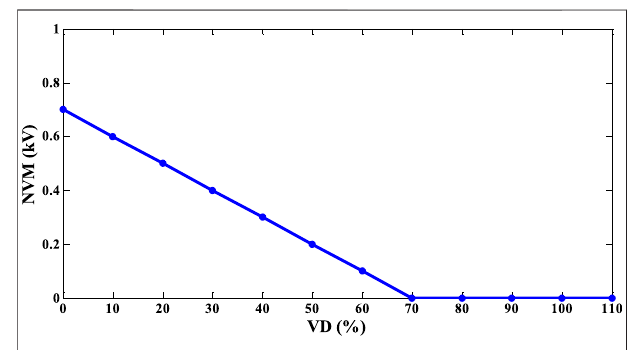
FIGURE 4 | Schematic diagram of the relationship between indicator NVM and indicator